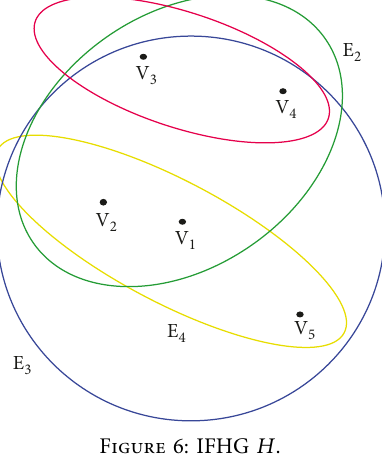
Figure 6: IFHG H .